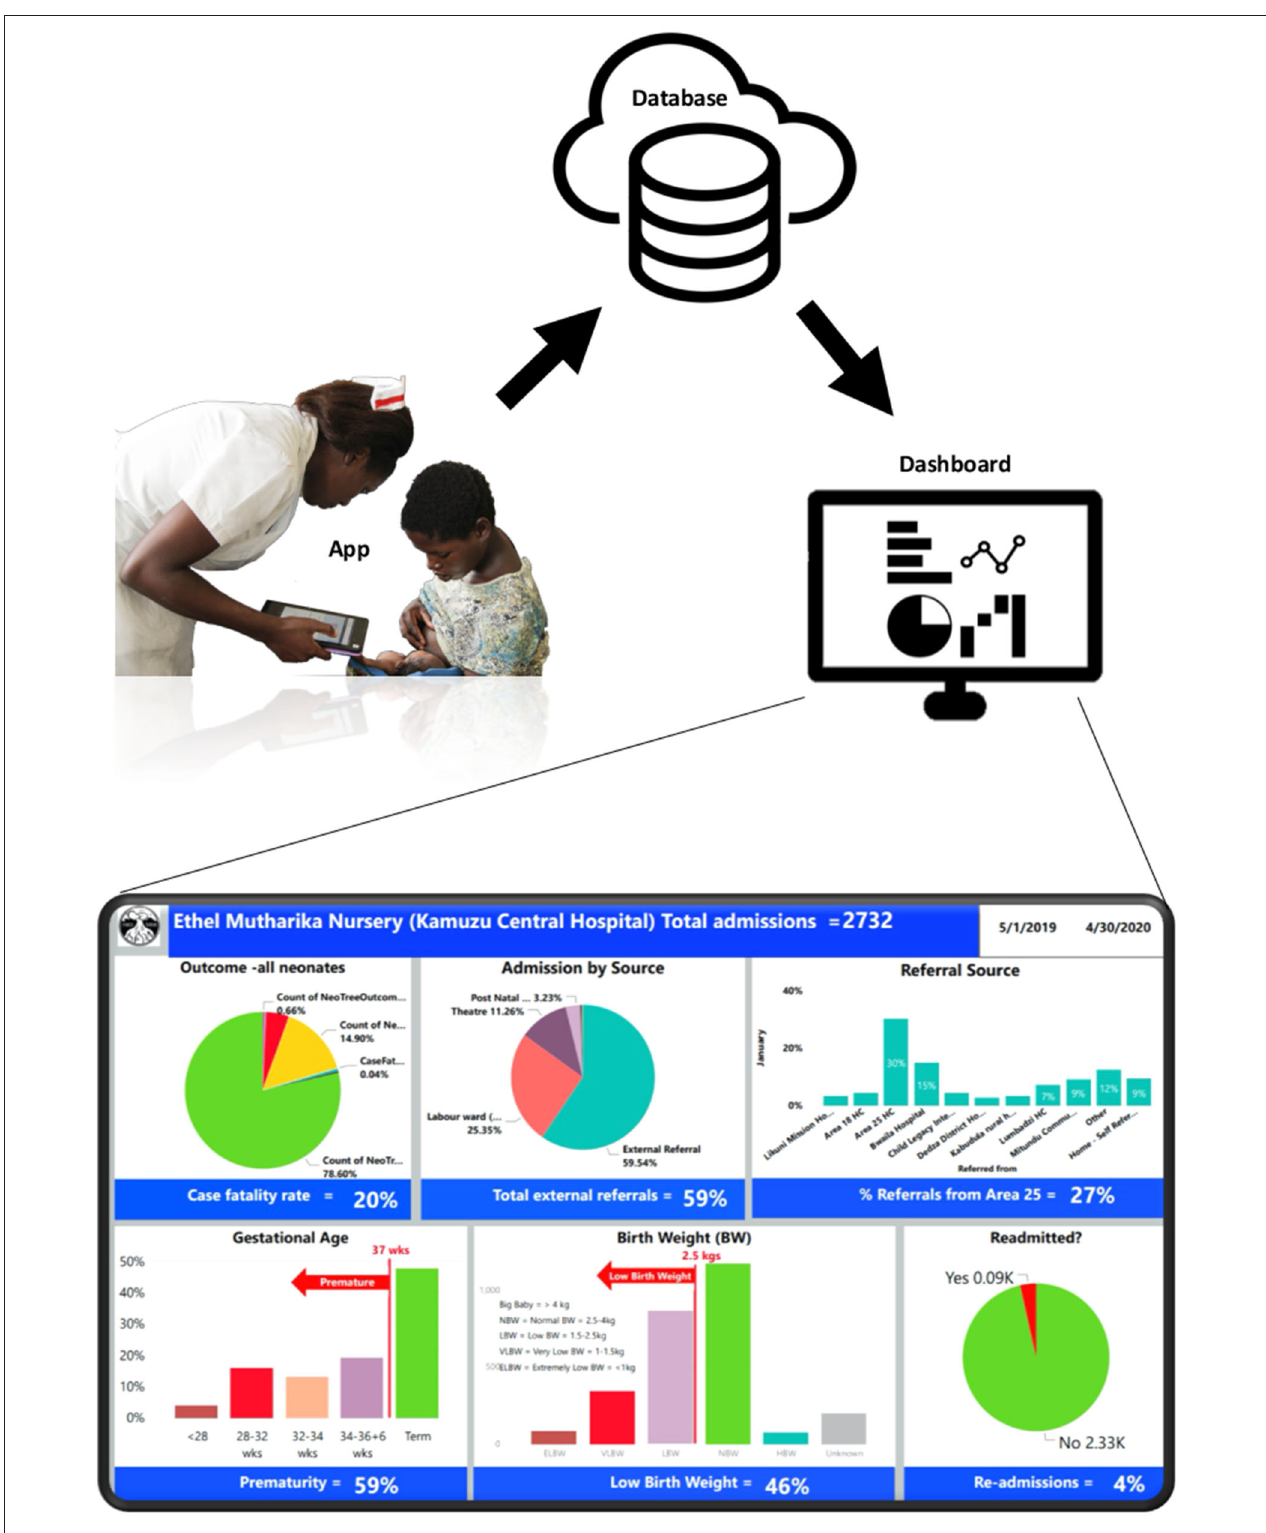
FIGURE 2 | NeoTree system components and dashboard summary screens displayed on the neonatal unit.